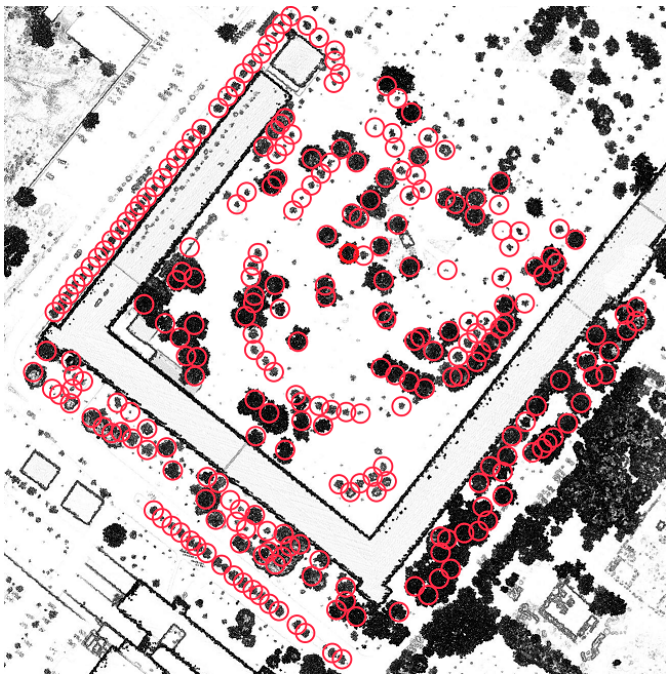
Figure 6. A total of 265 individual tree crowns (red circles) acquired with mean shift segmentation.